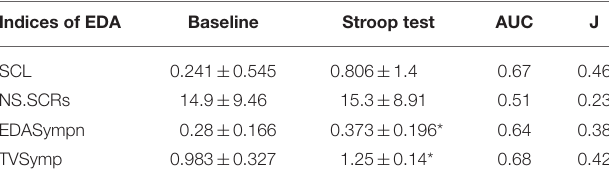
TABLE 3 | Measures of EDA